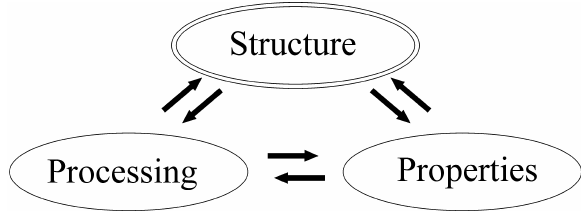
Figure 1. The matrials science paradigm shows that structure connects processing with